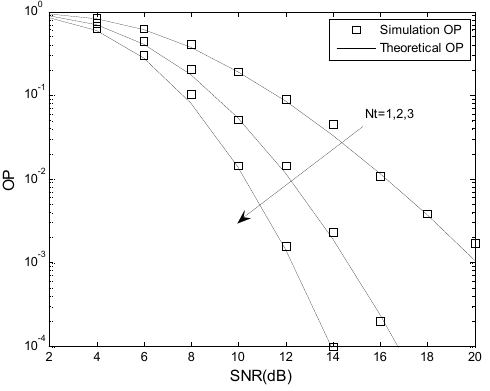
Figure 7. The OP performance of the suboptimal TAS scheme when γ th > γ P .